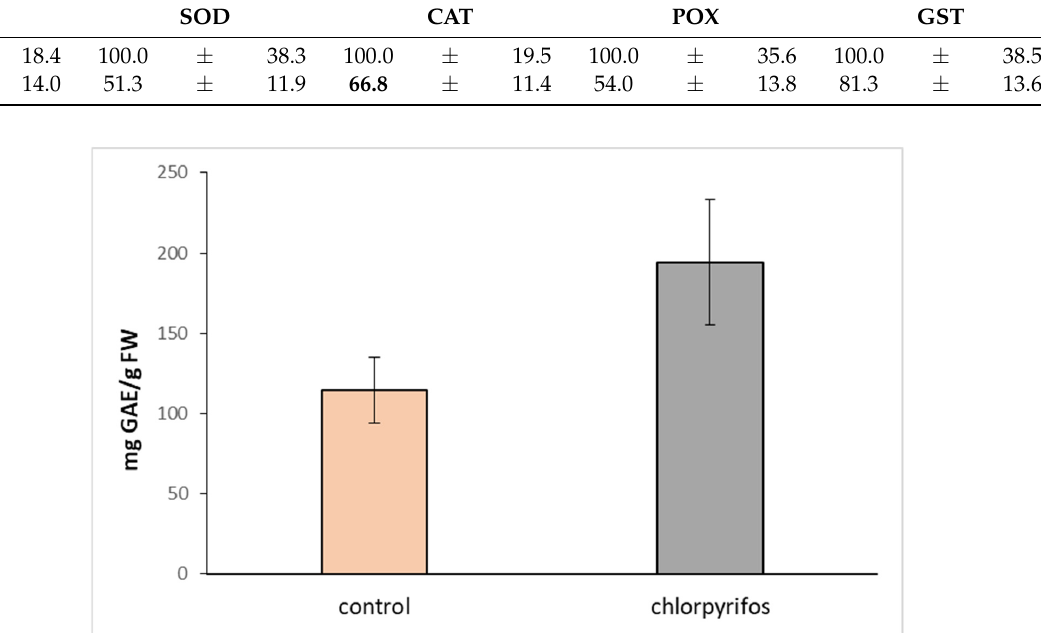
Table 2. Activity of antioxidant enzymes (APX—ascorbate peroxidase; SOD—superoxide dismutase; CAT—catalase; POX—peroxidase; GST—glutathione-S-transferase) in leaves of the hybrid aspen after 7 days of exposure to 1 mg L − 1 CPS. The data are expressed as the percentage of controls (=100%) representing the mean ± S.D. ( n = 4). Values that show statistically significant ( p < 0.05) deviations from the control are in bold. Figure 3. Chlorophyll a , chlorophyll b, and carotenoid content in hybrid aspen growing in medium supplemented with CPS at an initial concentration of 1 mg L − 1 . Samples were collected after 7 days of cultivation. The data represent the mean ± S.D. ( n = 4). The statistical analysis did not show any significant difference ( p < 0.05).